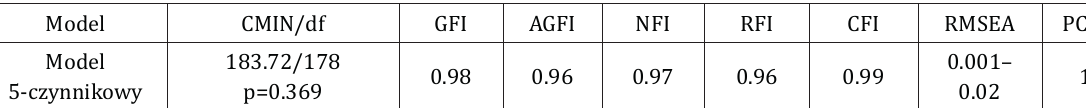
i tym samym potwierdza dobre dopasowanie modelu. Wartość RMSA wskazuje na trafność skonstruowanego modelu. Pozostałe miary (tab. 4) jak GFI oraz jego skorygowany odpowiednik AGFI, NFI, RFI, IFI, TLI, CFI wskazują, że model prawidłowo odzwierciedla charakter relacji zachodzących w populacji. Poziom istotności przypuszczenia o niedopasowaniu modelu PCLOSE jest nieistotny statystycznie (1,00) i również potwierdza dopasowanie modelu. weryfikującej trafność teoretyczną polskojęzycznej wersji HCS. Dane przedstawione na rycinie wskazują, że standaryzowane skonstruowany model jest akceptowalny, co jednocześnie potwierdza trafność teoretyczną adoptowanej skali. Trafność teoretyczną narzędzia potwierdza także analiza wyników przeprowadzona w różnych grupach oraz wyniki w zakresie korelacji pomiędzy takimi zmiennymi, jak wiek, wykształcenie, subiektywny stan zdrowia oraz spostrzegane zagrożenie chorobą. Poniżej znajdują się wyniki tych analiz. Oczekiwano, że poziom świadomości zdrowotnej u osób wykonujących zawód medyczny bądź posiadających wykształcenie medyczne będzie wyższy niż u pozostałych